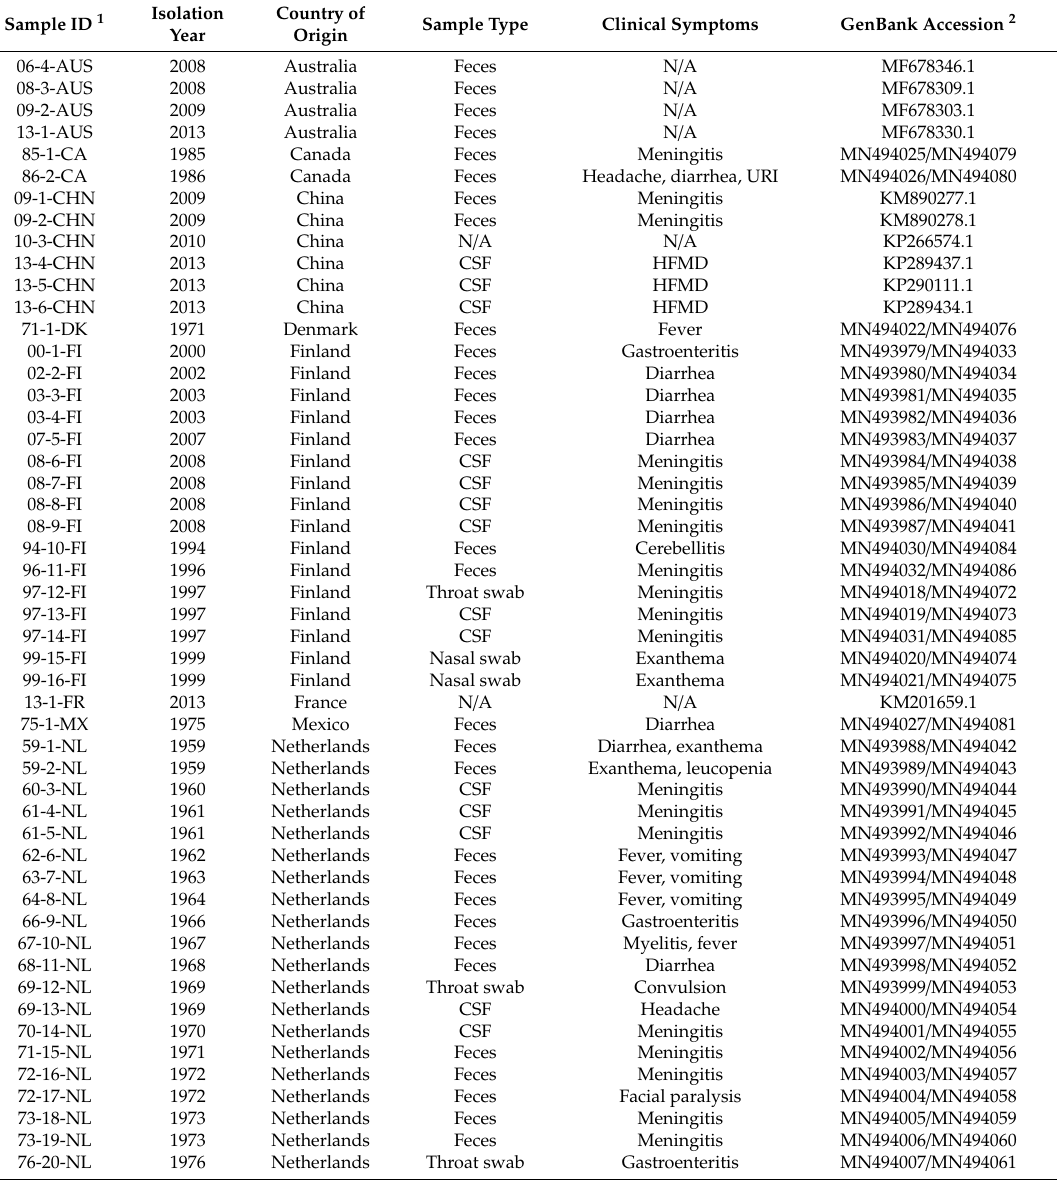
Table 1. CVA9 sample isolation years, countries, sample types, symptoms, and accession numbers. Sample ID